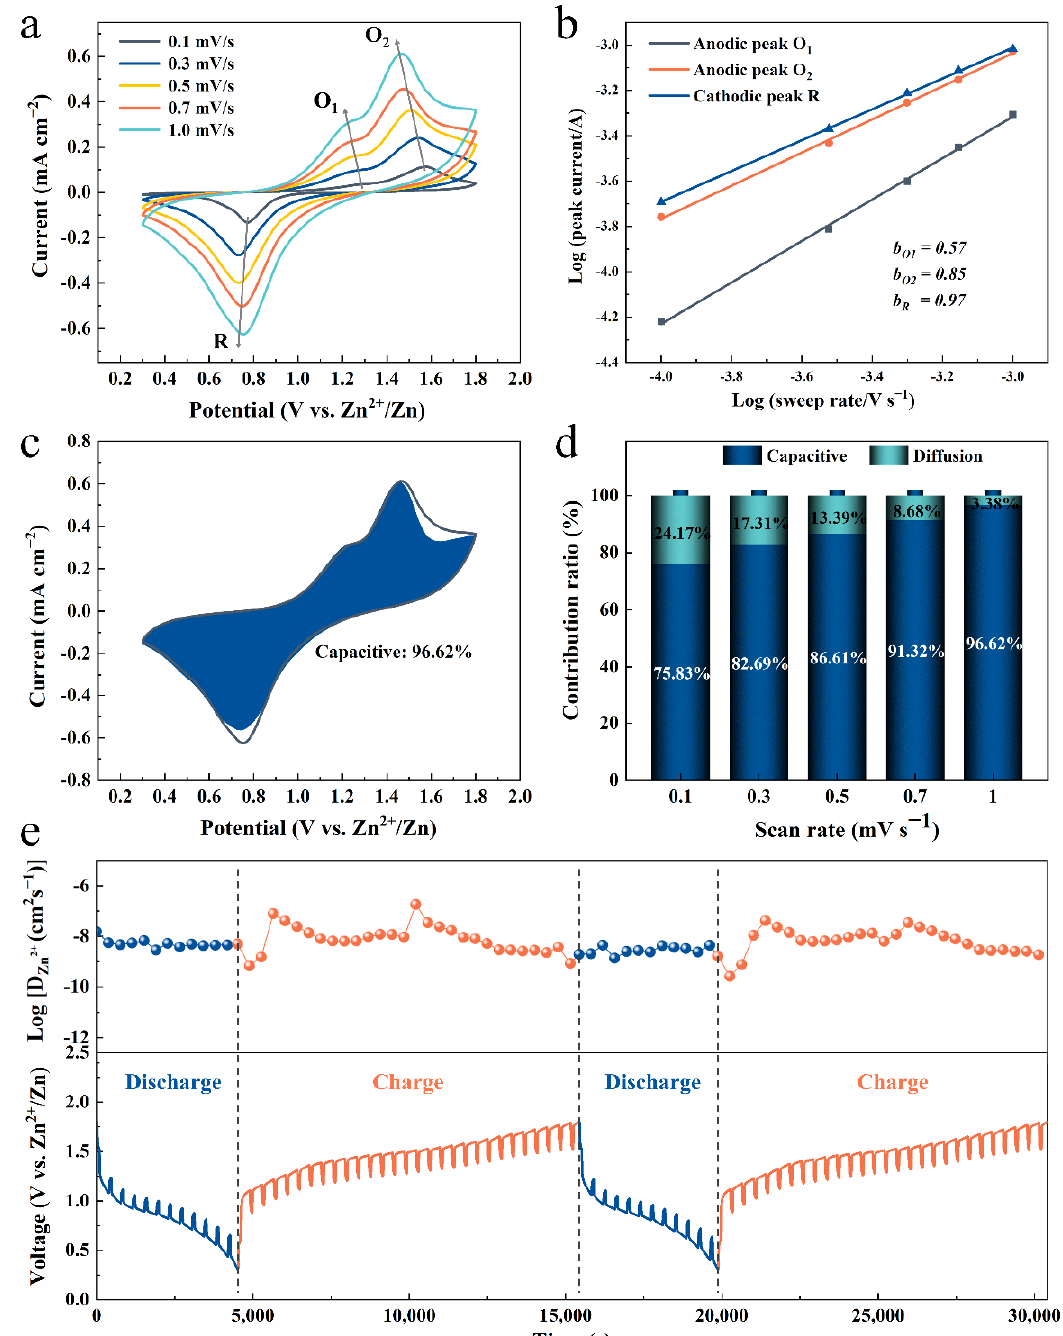
Figure 4. Diffusion kinetics characterization of PANI cathode. ( a ) CV curves of PANI electrode at different scan rates. ( b ) log( v ) vs. log( i ) plots at the peak current. ( c ) Contribution ratio of diffusion ‐ controlled vs. capacitive ‐ controlled capacities obtained at 0.1 mV s − 1 . ( d ) Contribution ratio of diffusion ‐ controlled vs. capacitive ‐ controlled capacities at different scan rates. ( e ) GITT analysis results for PANI electrode and corresponding Zn 2+ diffusion coefficient.